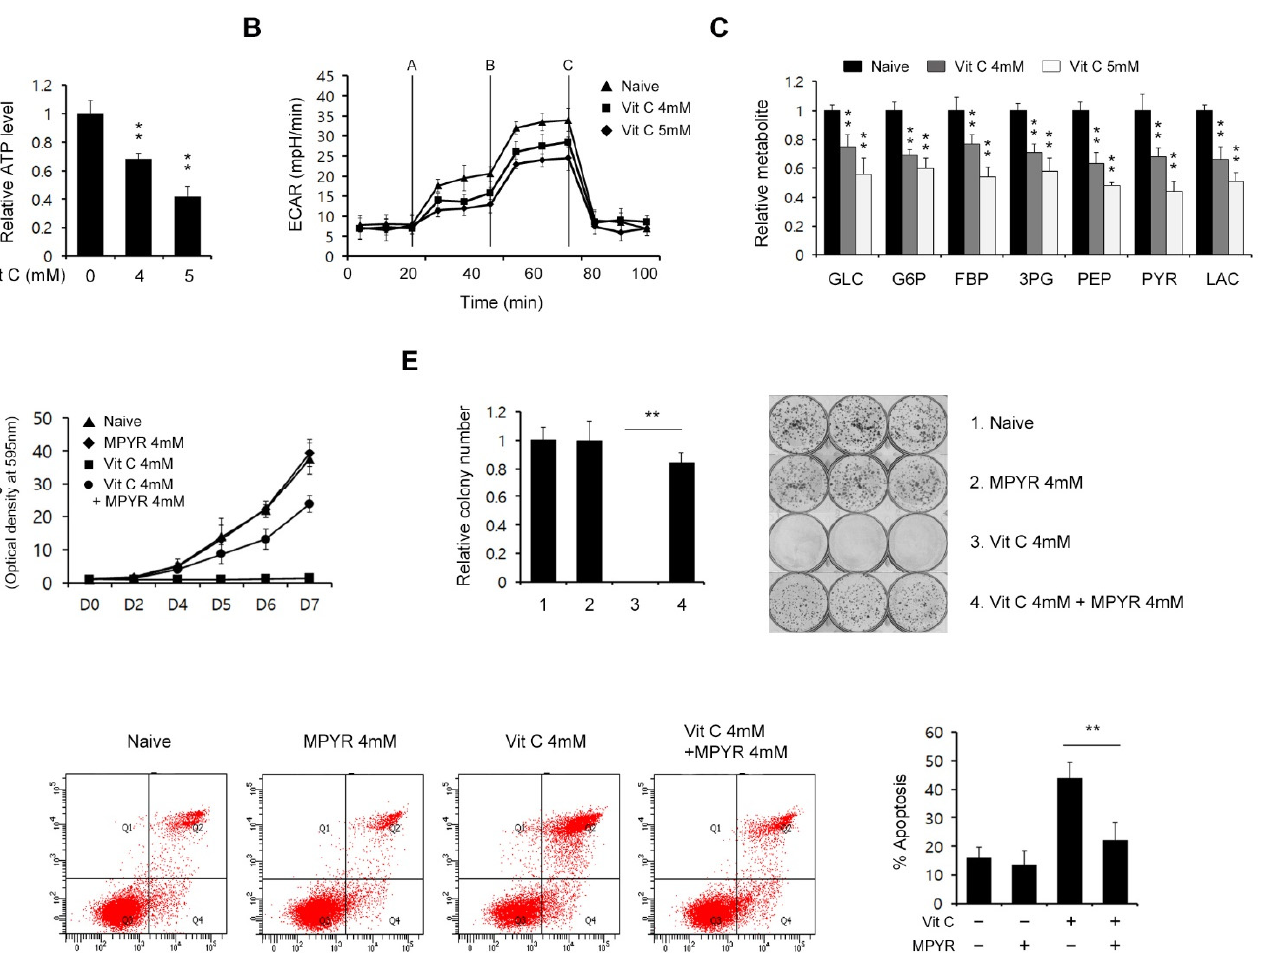
Figure 3. High-dose vitamin C suppresses the glycolytic flux in PDAC cells. ( A ) 8988T cells were treated with vitamin C (4 or 5 mM) for 24 h and assayed for intracellular ATP. ( B ) 8988T cells were treated with vitamin C (4 or 5 mM) for 24 h, and the extracellular acidification rate was measured. ( C ) 8988T cells were treated with vitamin C (4 or 5 mM) for 24 h and analyzed for glycolysis metabolite pools via LC/MS-MS. ( D ) Cell growth assay for 8988T cells treated with vitamin C (4 mM) for 8 days with or without methyl-pyruvate (4 mM). ( E ) Clonogenic assay for 8988T cells treated with vitamin C (4 mM) for 8 days with or without methyl-pyruvate (4 mM). Error bars represent the s.d. of triplicate wells from a representative experiment. ( F ) 8988T cells were treated with vitamin C (4 mM) for 8 days with or without methyl-pyruvate (4 mM) and assayed for apoptotic cell death by annexin V/PI staining and flow cytometry. Error bars represent the s.d. of triplicate wells from representative experiments; ** p <